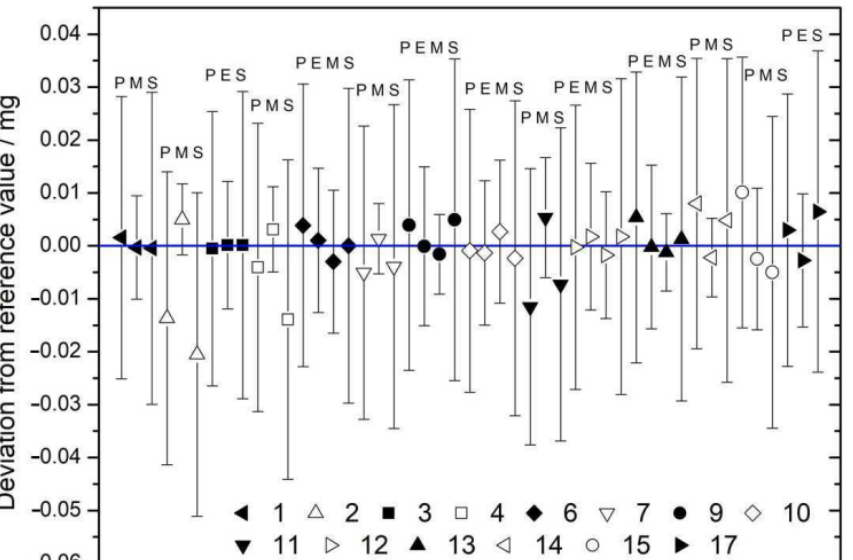
Figure 18. Deviation between results and the comparison reference value (blue line). P—pycnometer, E—elimination, M—MEM and S—substitution.